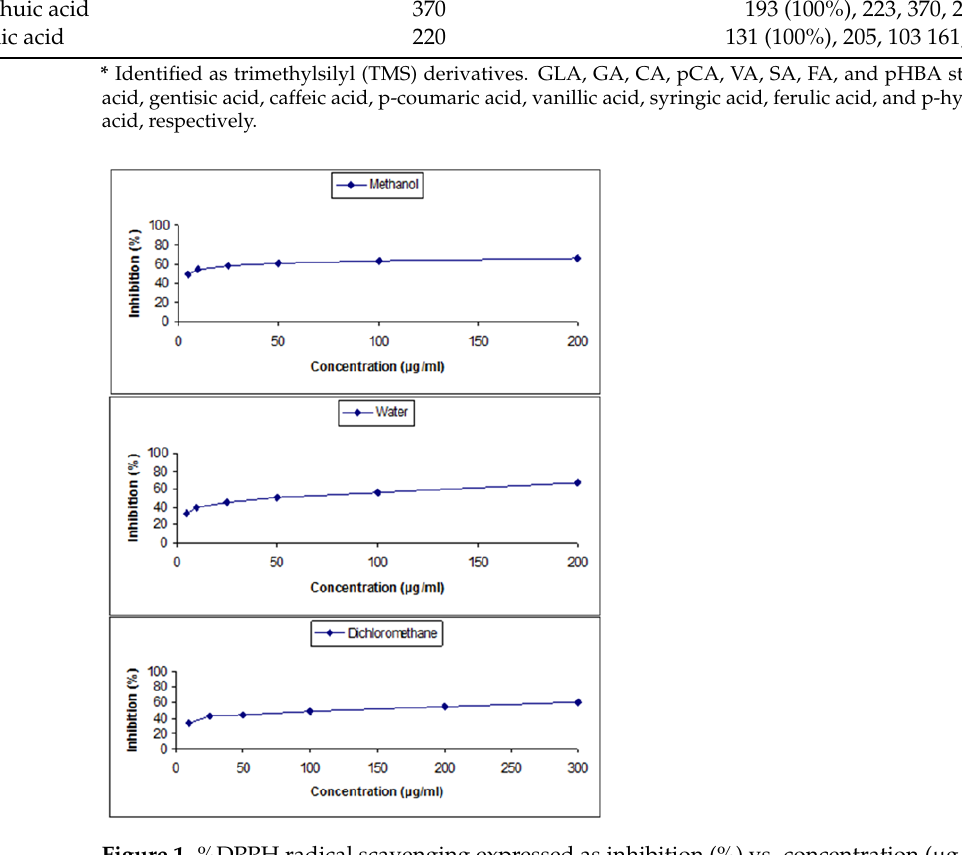
Figure 1. %DPPH radical scavenging expressed as inhibition (%) vs. concentration (μ g/ml) curves for IC 50 values determination of Salvia officinalis